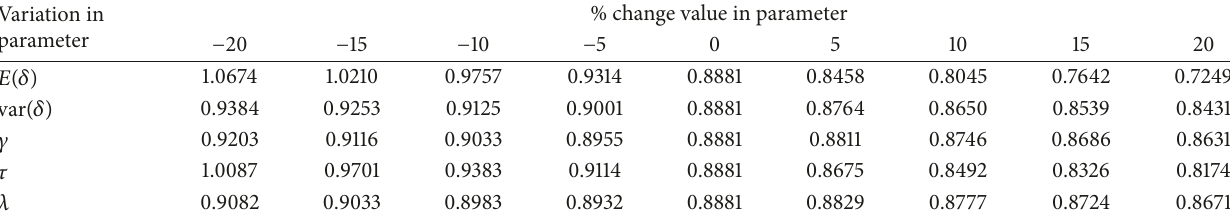
Table 5: Effects of changing four categories of parameters on Π 𝐺 .